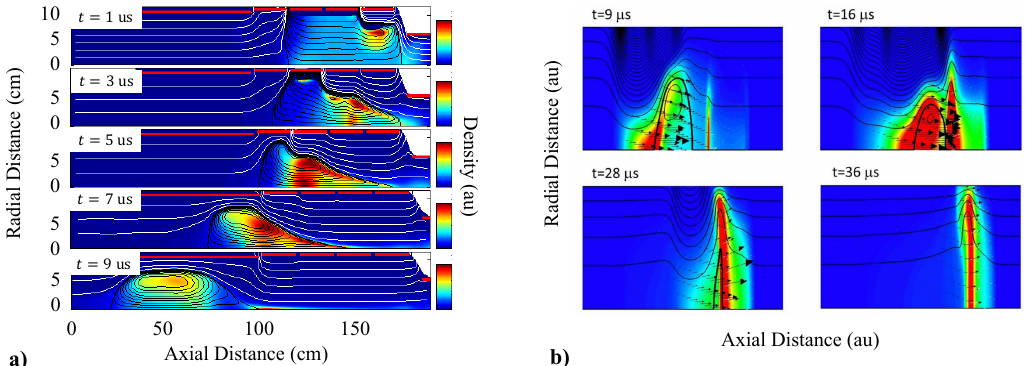
Figure 21. Neutral density psuedocolor plots for baseline ELF simulation with a Gaussian radial neutral gas Figure 8. Flux and density contours for a numerical profile. Black and white arrows indicate the direction and magnitude of plasma and neutral momentum, calculation of the MAP thruster as constructed for respectively. Clear neutral entrainment is seen. initial acceleration experiments. Black lines are flux Figure 18. Numerical simulations of FRC thrusters: ( a ) Moqui simulation showing acceleration of contours in the FRC. Axis and density bars are in units of cm. a plasmoid using sequentially pulsed magnets (from [80]; reproduced with permission of Electric Rocket Propulsion Society), ( b ) SEL-HiFi simulation shows neutral entrainment by a translating FRC (from [81]; reproduced with permission of the